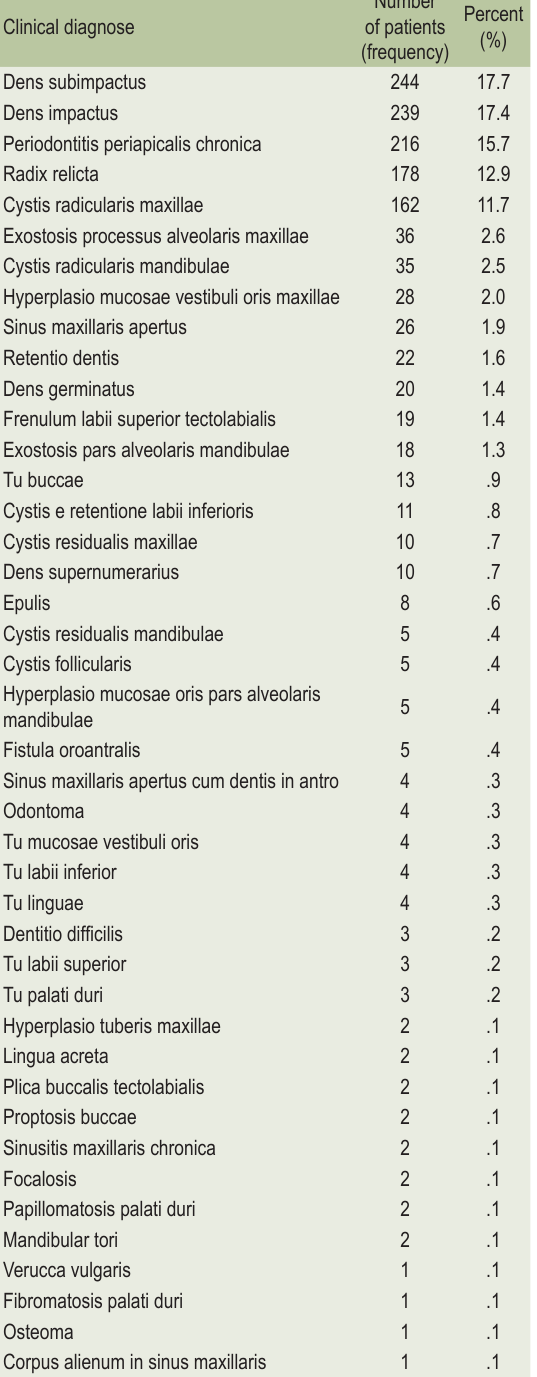
TABLE 1. Clinical diagnoses of oral surgical procedures performed at Department of Oral Surgery, Faculty of Dentistry Sara- jevo, from January 2011 to December